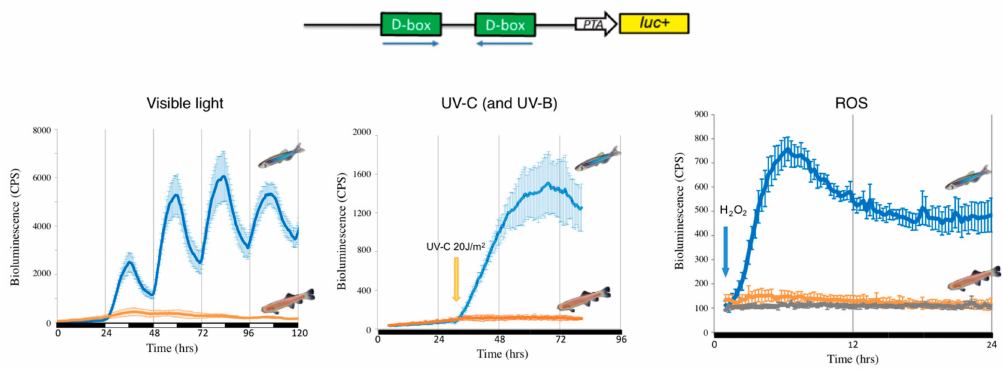
Figure 2. Loss of D-box function in cavefish. Representative in vivo bioluminescence assays performed in zebrafish (blue traces) and cavefish (orange traces) of cells transfected with the D-box enhancer luciferase reporter derived from the zebrafish 6-4 phr promoter [122] (upper part of the figure). Cells were exposed to three di ff erent stressors: light-dark cycles (left panel), a UVC pulse (central panel) or 300 µ M H 2 O 2 (right panel). The grey (right panel) trace indicates luciferase expression of cavefish cells not exposed to H 2 O 2 (negative controls). Black and white bars below each panel indicate the lighting